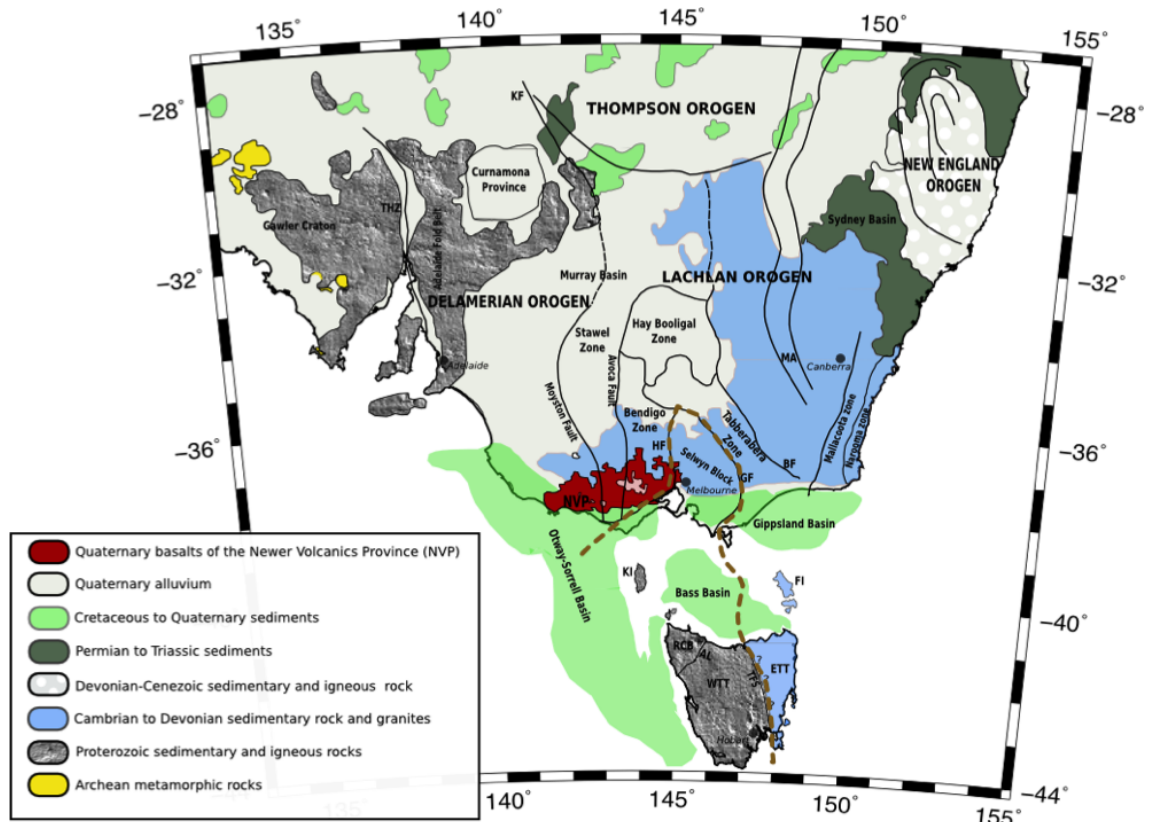
Figure 1. Regional map of southeastern Australia that shows key geological boundaries and the location of observed or inferred tectonic units (modified from Bello et al., 2019a). Thick black lines delineate structural boundaries, and the thick brown dashed line traces out the boundary of VanDieland. The following abbreviations are used in the figure: HF – Heathcote Fault; GF – Governor Fault; BF – Bootheragandra